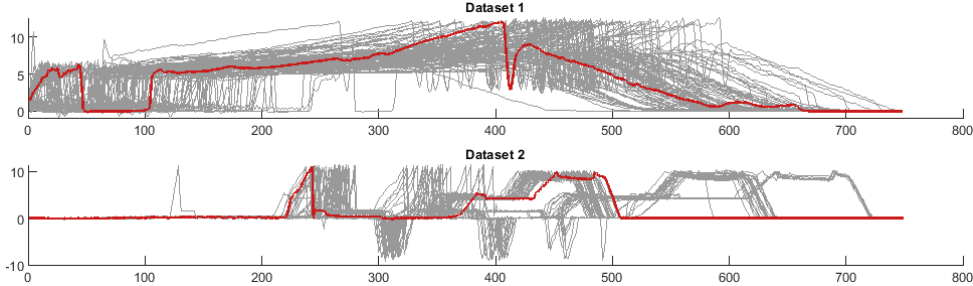
Figure 2. Datasets 1 and 2 with a random example of a single observation highlighted in red. Dataset 1 is a manual nut runner process with high variability. Dataset 2 is an automated process where the staging problem can be clearly